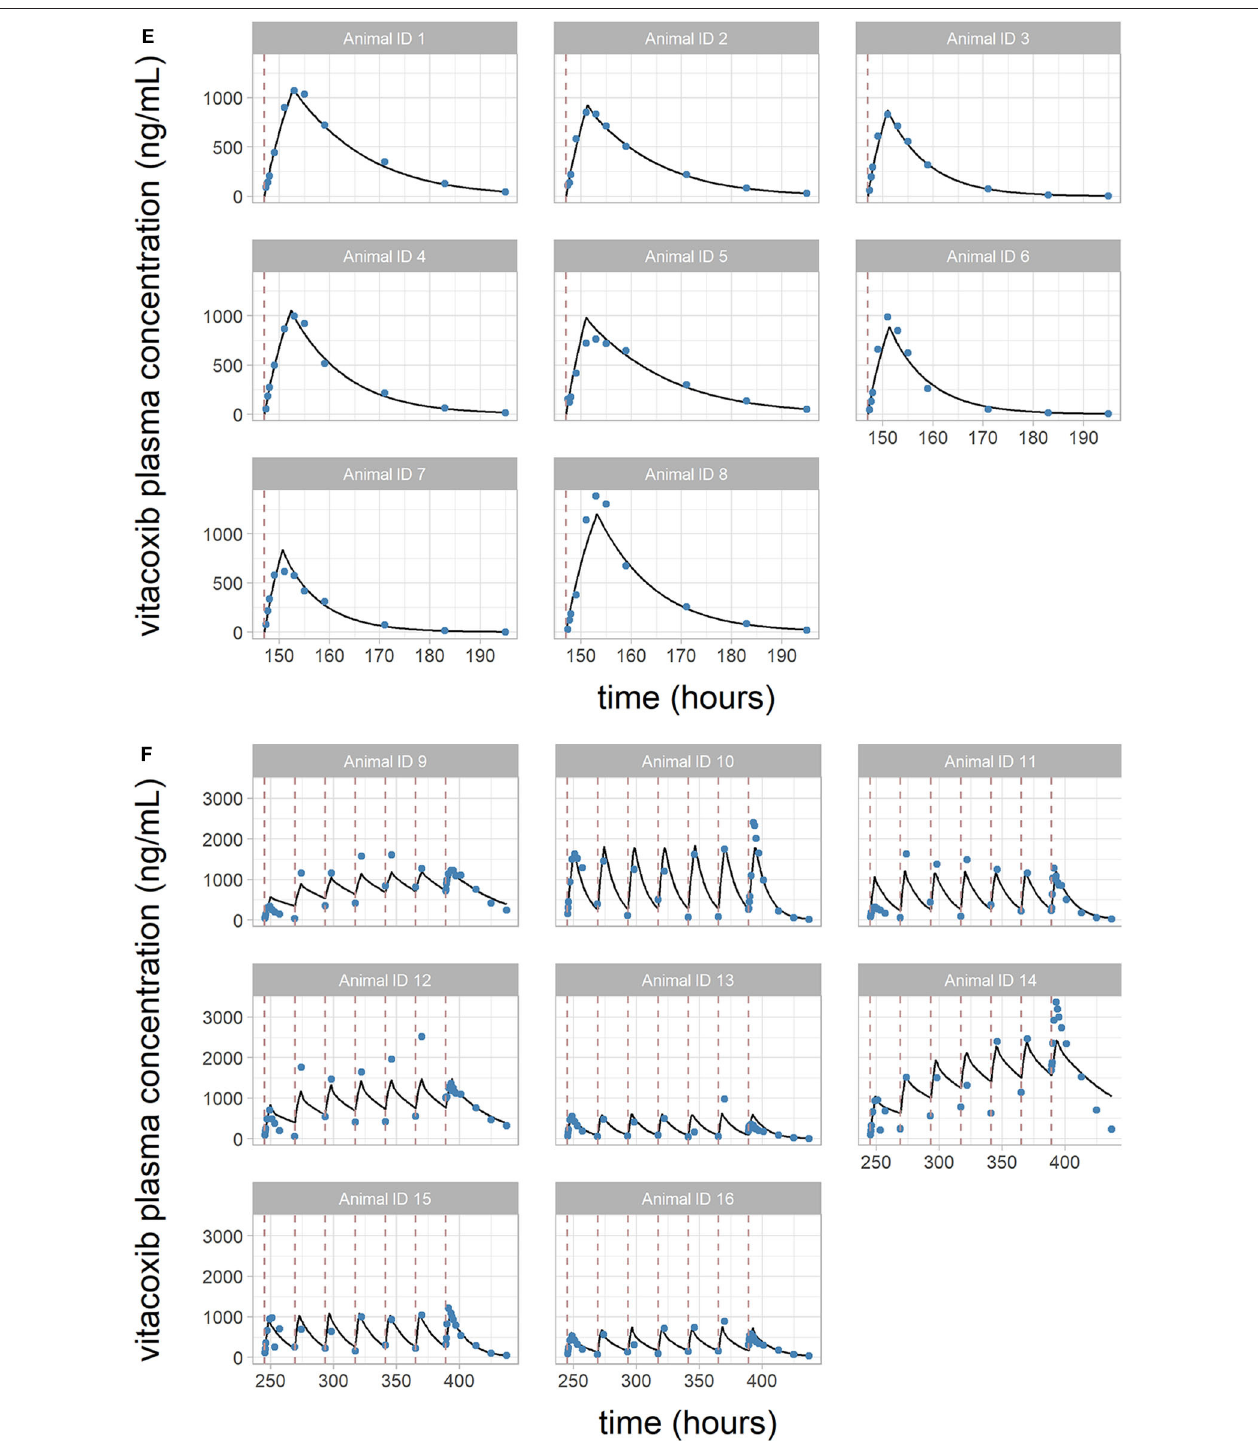
FIGURE 3 | (A–F) Individual predictions of vitacoxib plasma concentration in cats from the final selected model. Plots of individual observed (blue dot) and individual predicted (black line) vitacoxib concentration time course. Dosing events are indicated by dotted red lines. The full model was able to describe the individual time course of vitacoxib for all dosing schedules with excellent accuracy, as shown by the quality of the individual fits.